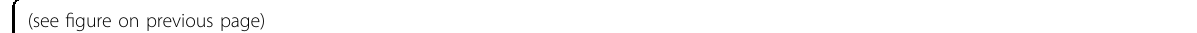
Fig. 1 BCL-X L is overexpressed and confers a survival dependency in MPM. A Genetic alterations and mRNA/protein expression of pro-survival Bcl-2 family genes in the TCGA cohort of MPM patients ( n = 87). Data were downloaded from the cBio Cancer Genomics Portal (CBioPortal). B , C The dependency pro fi le of pro-survival BCL-2 family genes ( BCL2L1, BCL2L10, BCL2, BCL2A1, BCL2L2, and MCL1 ) in MPM cell lines based on genome-wide CRISPR (NCIH28, NCIH2452, MPP89, NCIH2052, ISTMES2, MERO14, and MSTO-211H) or RNAi interference (MPP89, ACCMESO-1, NCI-H28, NCIH2452, NCI- H2052, and JL-1) screens. Data were downloaded from The Cancer Dependency Map Project (DepMap) datasets: CRISPR (Avana) Public 19Q3 and Combined RNAi (Broad, Novartis, Marcotte). D Volcano plot of transcriptomic comparison between patients ’ MPM samples ( n = 40) versus normal pleural tissues ( n = 5) (GSE2549). Genes signi fi cantly downregulated (adjusted p value <0.05) are shown in green and genes signi fi cantly upregulated in red. The differentially expressed pro-survival Bcl-2 family genes are highlighted. E Immunoblots of BCL-X L in human normal fi broblasts (hFb16Lu), normal mesothelial cells (LP-9), and MPM cells. Proteins lysates prepared from the cells were subjected to serial dilutions (100, 75, and 50%) for immunoblot analysis (left). Densitometric analysis of the immunoblot (right) showed fold change of BCL-X L signal normalized against Actin and the total protein, with the value of hFb16Lu cells set to 1. F BCL-X L protein level in TCGA pan-cancer cohort ( n = 32). The expression pro fi le was obtained from The Cancer Proteome Atlas (TCPA). READ rectum adenocarcinoma, CHOL cholangiocarcinoma, MESO mesothelioma, COAD colon adenocarcinoma, LUAD lung adenocarcinoma, SKCM skin cutaneous melanoma, LUSC lung squamous cell carcinoma, THCA thyroid carcinoma, UCEC uterine corpus endometrial carcinoma, PAAD pancreatic adenocarcinoma, GBM glioblastoma multiforme, KICH kidney chromophobe, BLCA bladder urothelial carcinoma, HNSC head and neck squamous cell carcinoma, PRAD prostate adenocarcinoma, OV ovarian serous cystadenocarcinoma, LGG brain lower grade glioma, THYM thymoma, STAD stomach adenocarcinoma, DLBC lymphoid neoplasm diffuse large B-cell lymphoma, TGCT testicular germ cell tumors, BRCA breast invasive carcinoma, KICH kidney chromophobe, KIRP kidney renal papillary cell carcinoma, UVM uveal melanoma,